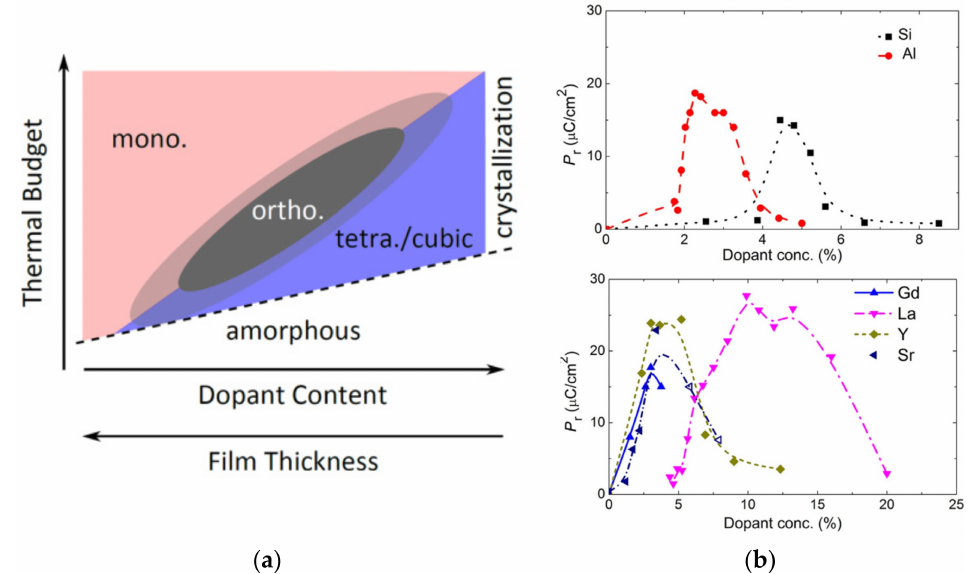
Figure 1. ( a ) A qualitative model of film conditions, crystal, and thermal budget [31] Copyright 2015, AIP Publishing LLC. ( b ) Remnant polarization of ferroelectric HfO 2 film as a function of dopant content and doping concentration. Reproduced with permission [23]. Copyright 2019, Elsevier